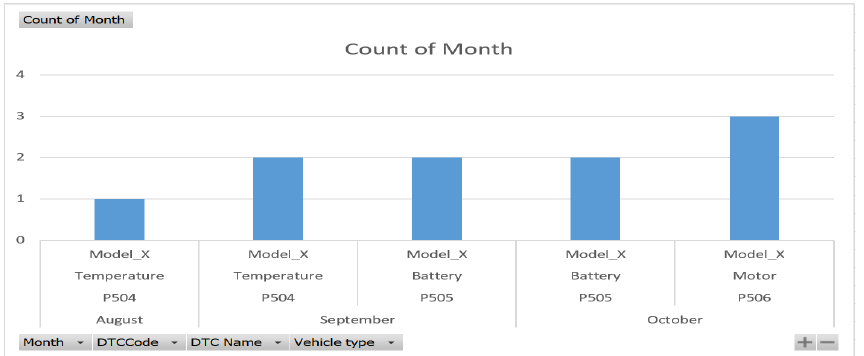
Figure 23. The history for one vehicle and all its logged DTC with timeline (used by vehicle’s user for analysis of performance).